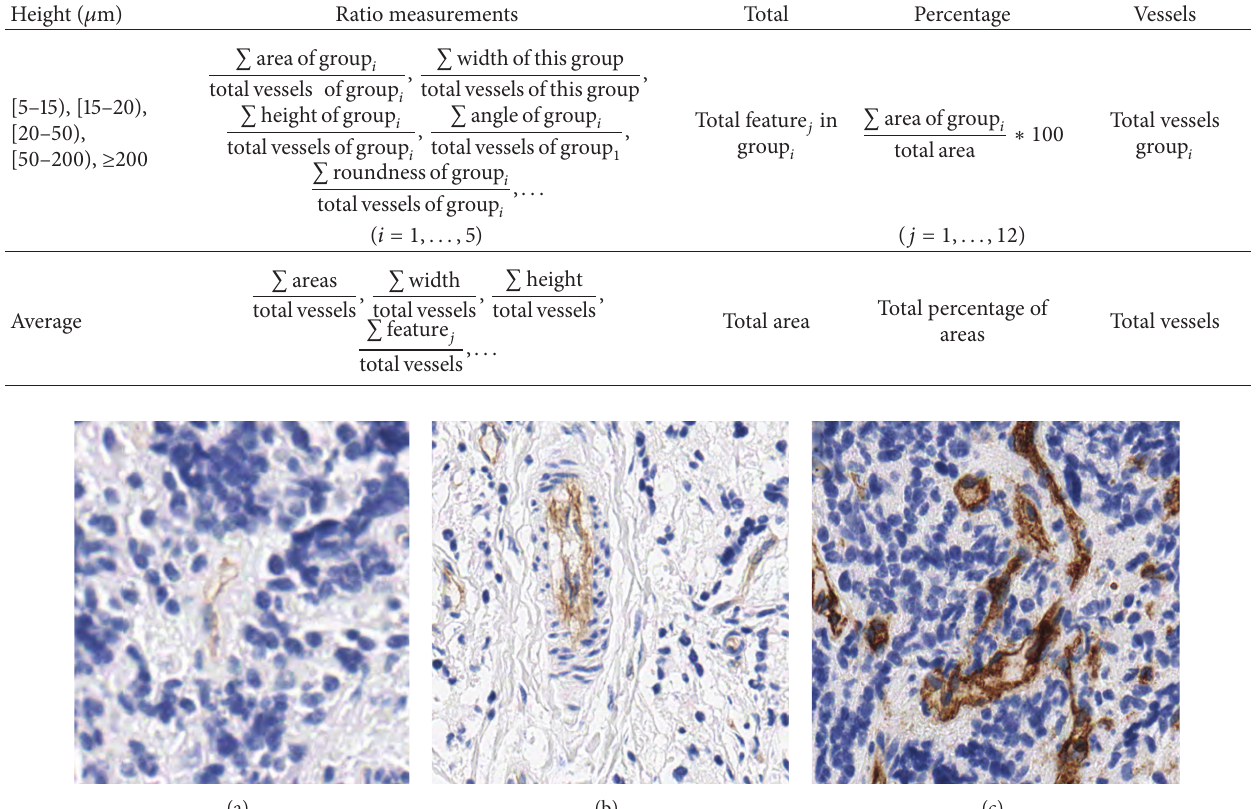
Figure 2: Vessels in TMA samples with different degrees of staining. (a) Weak stain, (b) normal stain, and (c) strong stain.